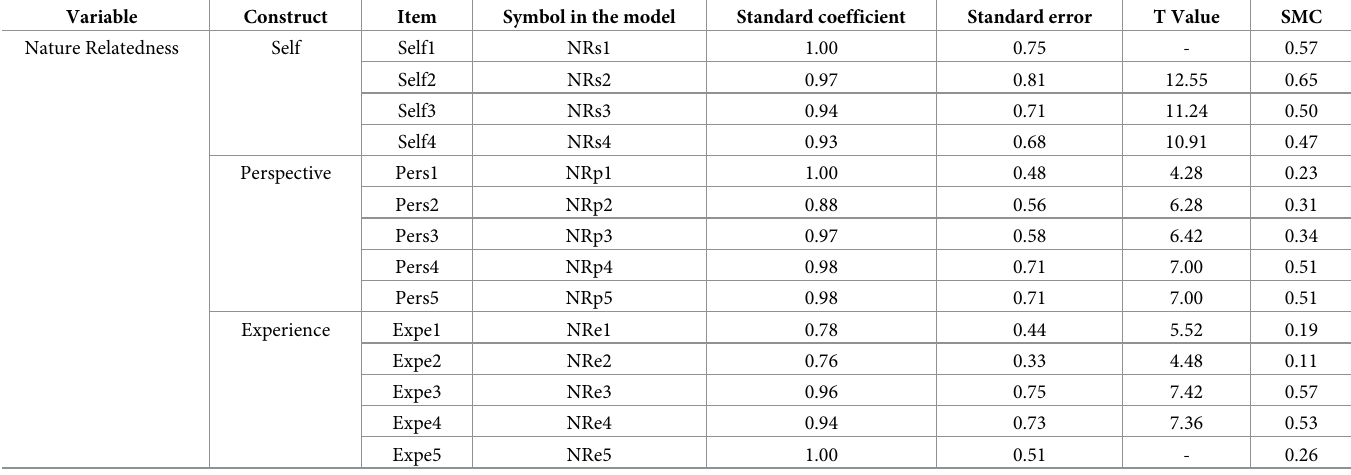
Table 7. Summary of the results obtained from the second-order